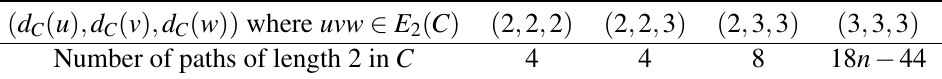
Table 8 Partition of paths of length 2 of the graph C